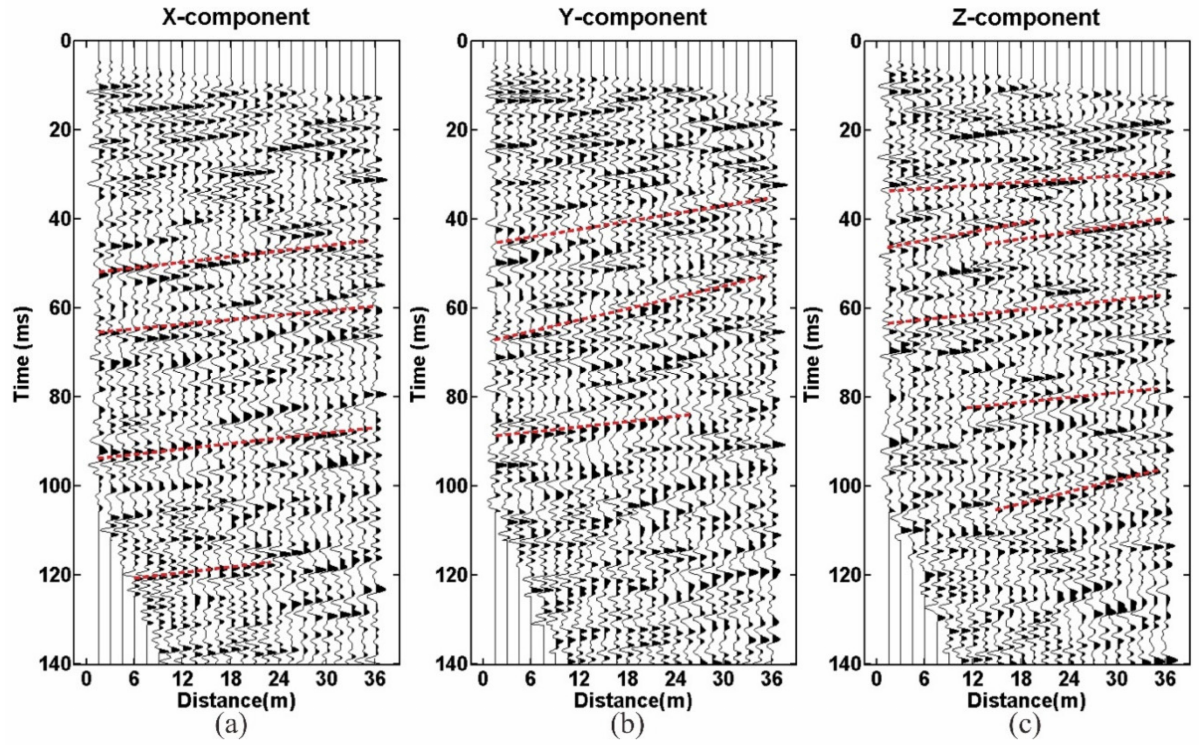
Figure 13. The processed data of geophone R-2: ( a ) X-component; ( b ) Y-component; ( c )